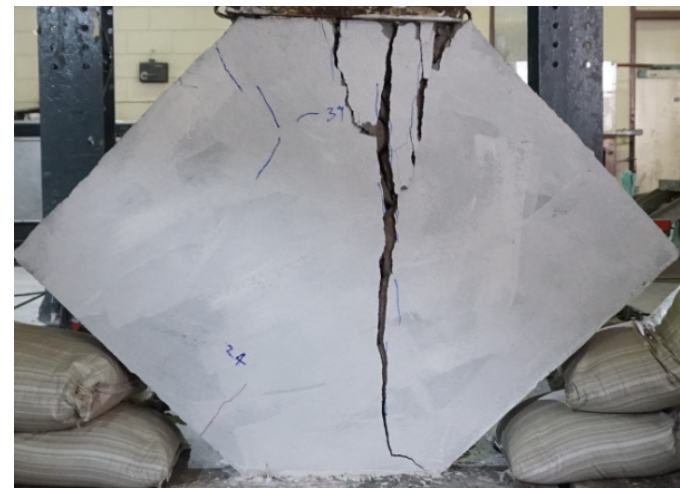
Figure 20. Failure of wall (W-PC1-10).